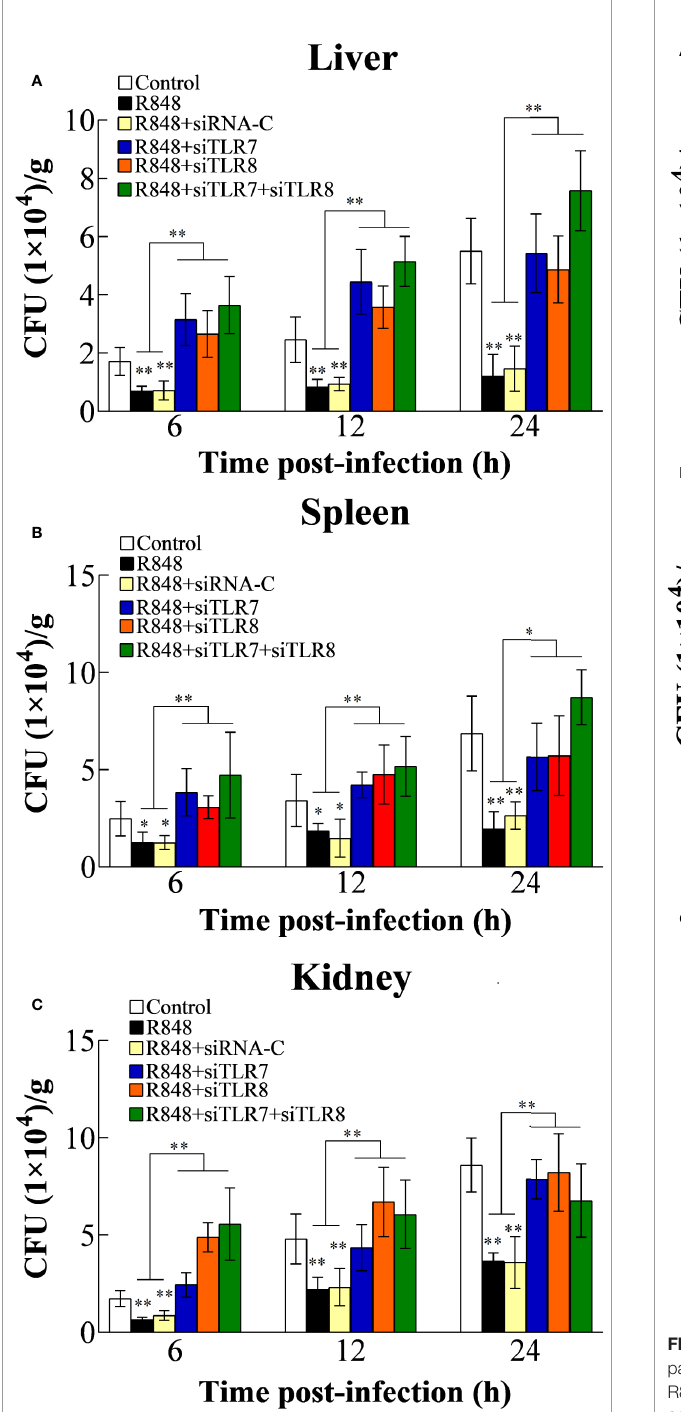
FIGURE 7 | Effect of R848 on bacterial infection through TLR7/8-signaling pathway. Golden pompano administered with R848, R848 plus siRNA-C, R848 plus siTLR7, R848 plus siTLR8, R848 plus siTLR7 and siTLR8, or PBS (control) were infected with Edwardsiella tarda , and the amount of bacteria in the liver (A) , spleen (B) , and kidney (C) were determined at different time points. All data are shown as the means ± SD (N = 5), and the statistical signi fi cance is indicated. **P < 0.01.